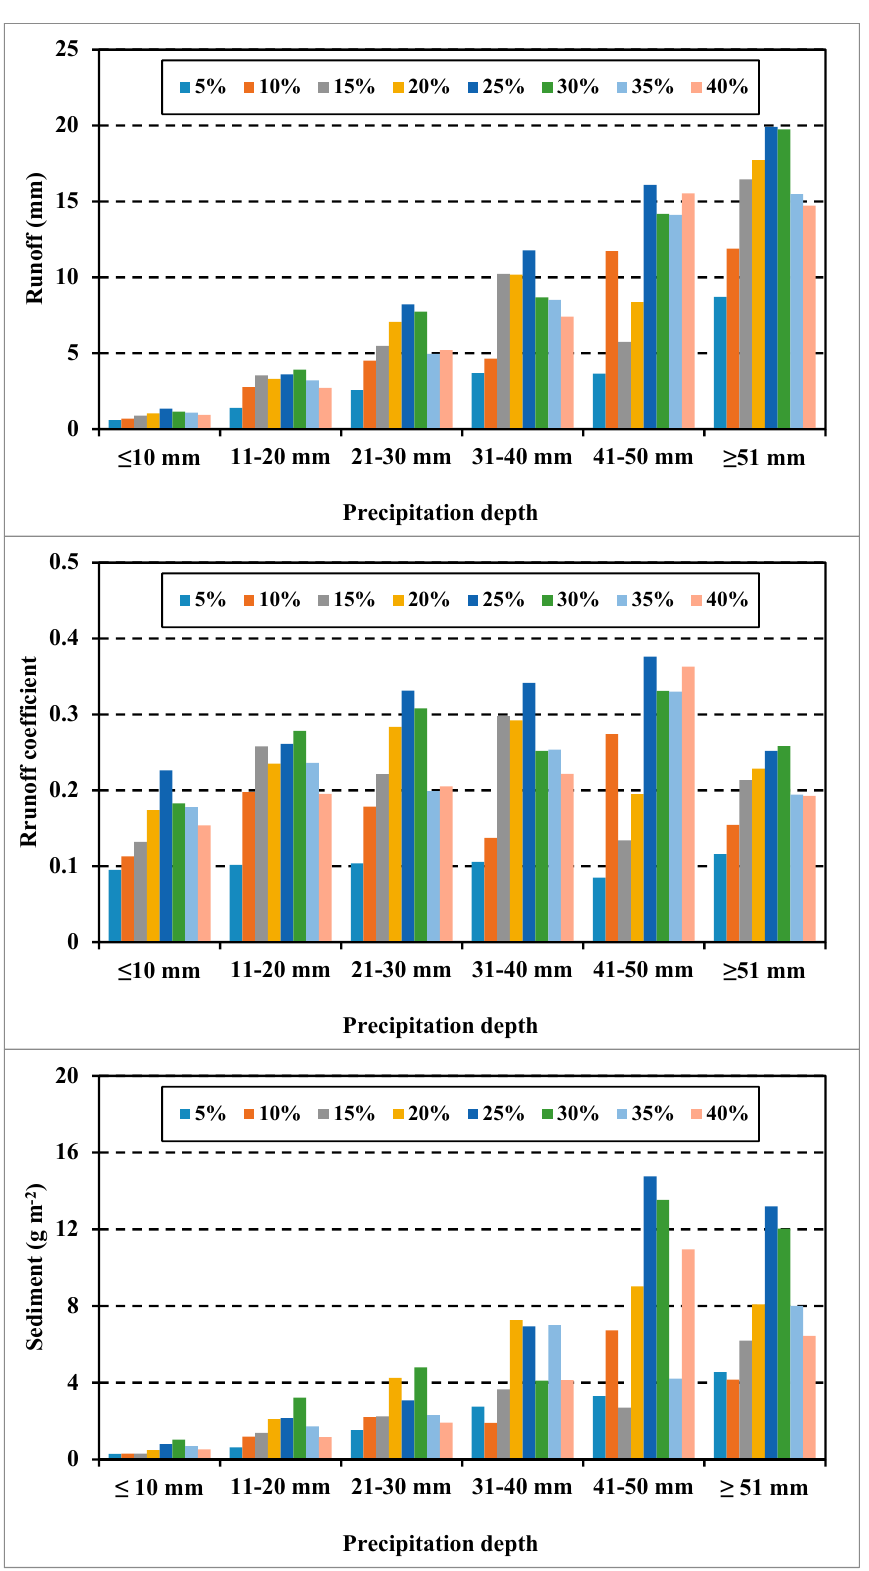
Figure 4. Average runoff, runoff coefficient, and sediment on the slope gradient (showed by different colors) at different value of precipitation depth.